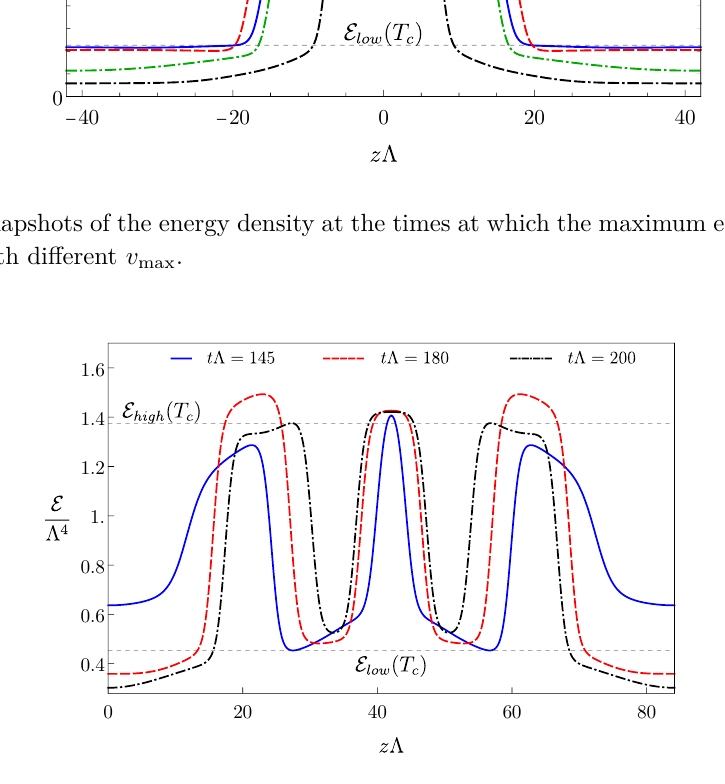
Figure 21 . Snapshots of the energy density for the collision of figure 19(top) with v max = 0 . 25 . The blue curve corresponds to a time soon after the fragmentation of the excited state. Note that the horizontal axis in this figure has been shifted to show the new domain at the center of the figure and the central fragments on the sides of